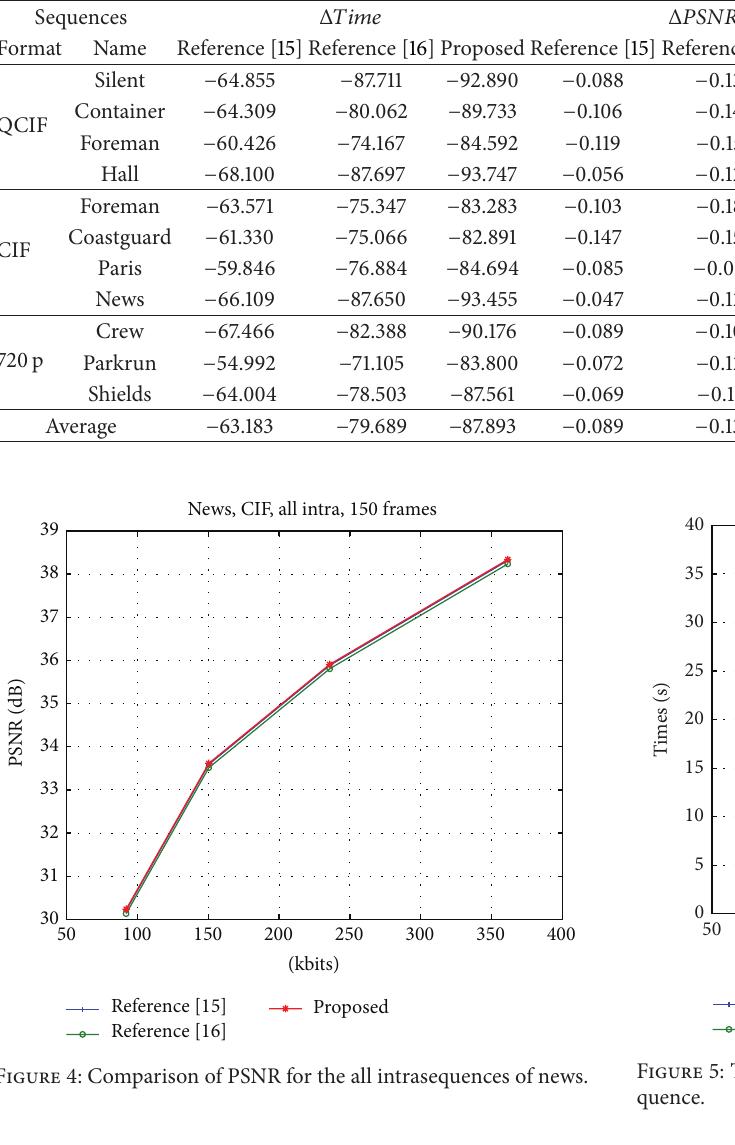
PSNR and, respectively, 1.454% and 1.828% increments in bitrate.